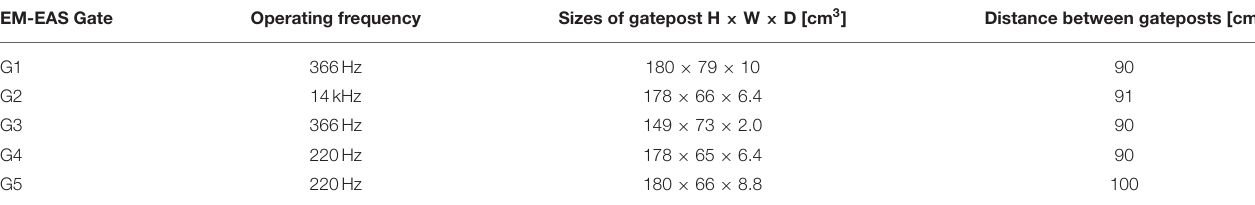
TABLE 1 | Specifications of investigated EM-EAS gates. EM-EAS